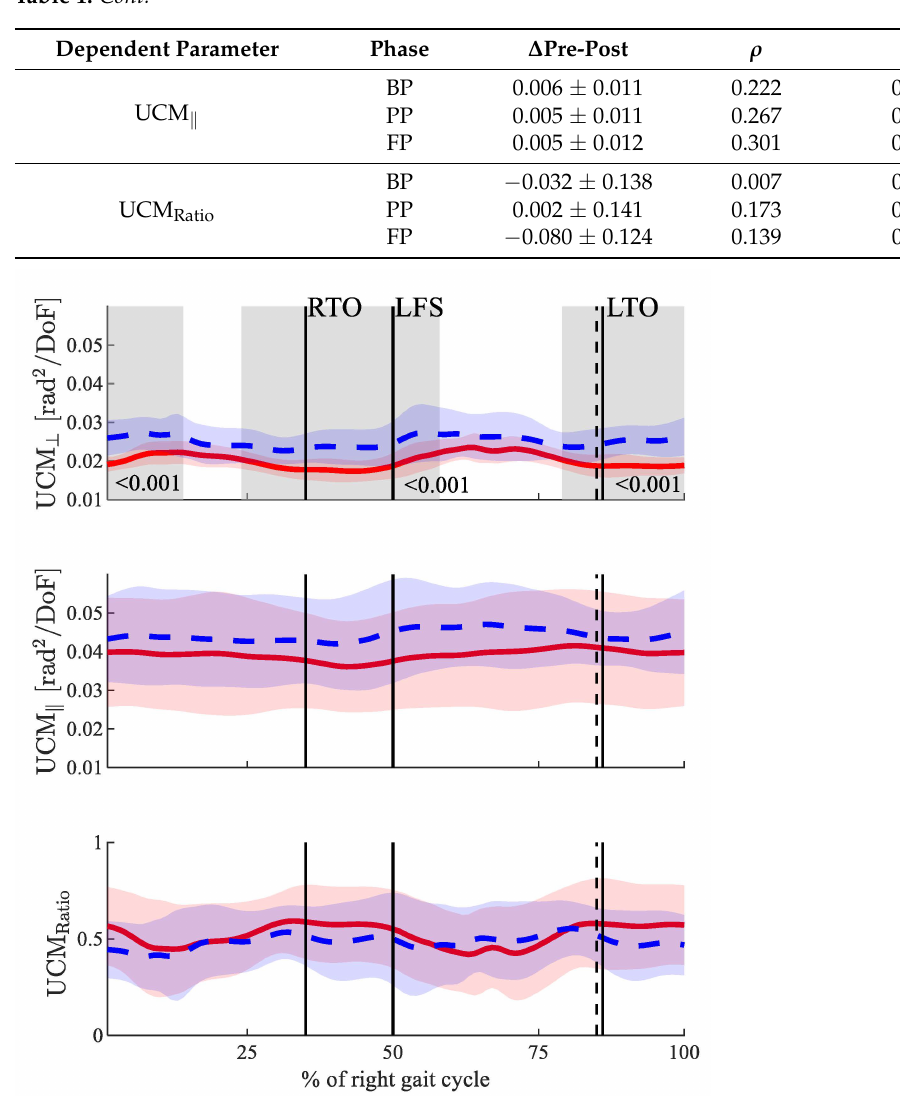
Figure 2. Results for the three dependent UCM parameters. From top to bottom: UCM and UCM Ratio . The solid red line shows the results PRE fatigue, and the dashed blue line shows the results POST fatigue. The perpendicular black lines show the gait events right toe off (RTO), left foot strike (LFS) and left toe off (LTO). Solid lines are the gait events PRE fatigue, and dashed lines are the gait events POST fatigue. Significant differences are highlighted in